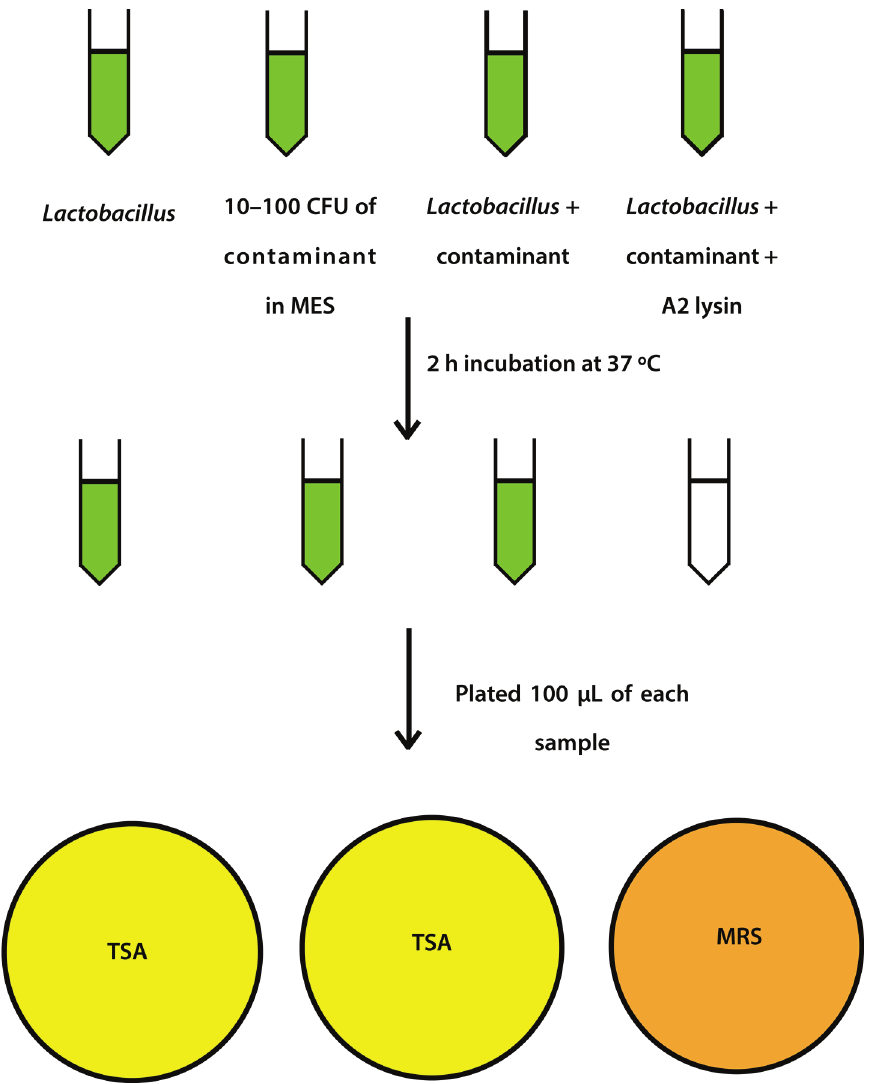
Figure 1. Schematic representation of spiking experiment.